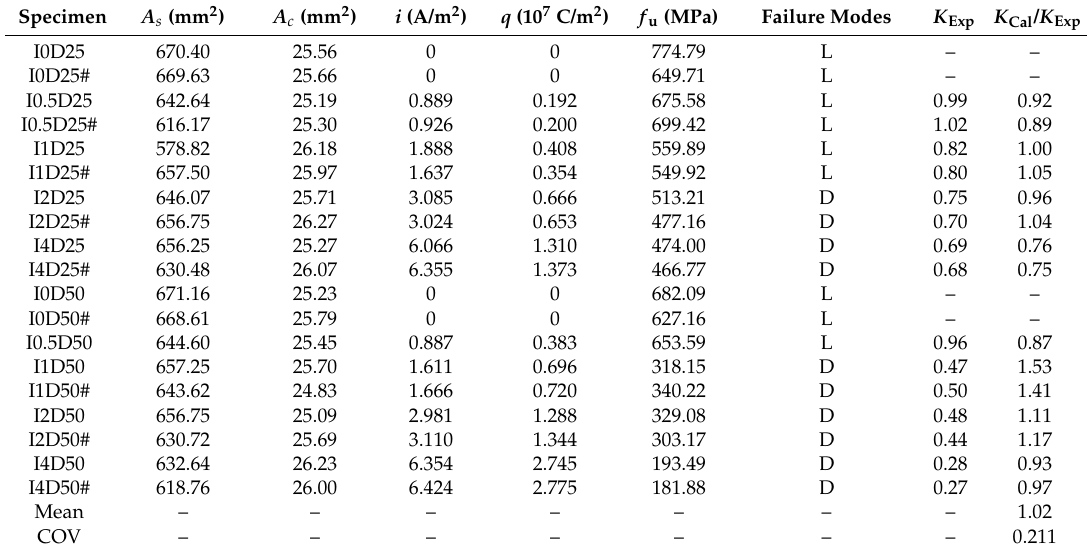
Table 3. Parameters and test results for specimens used for tensile tests after polarization.